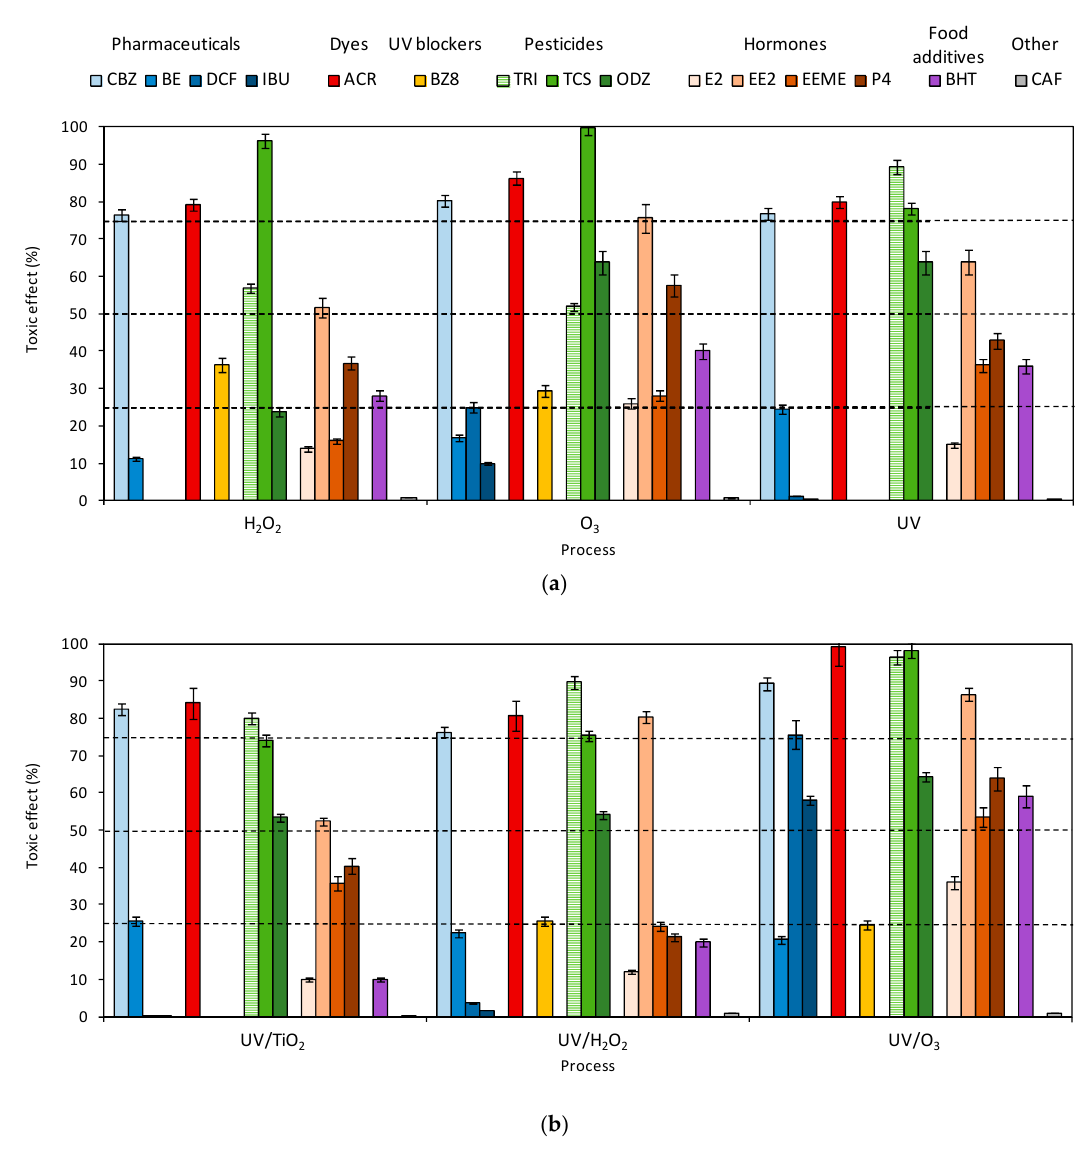
Figure 19. Change in the toxicity of the micropollutant water solution after ( a ) single oxidation processes (dose of H 2 O 2 = 12 mg L − 1 ; dose of O 3 = 10 mg L − 1 ; 60 min of UV irradiation) and ( b ) selected combinations of AOPs (60 min of UV irradiation).